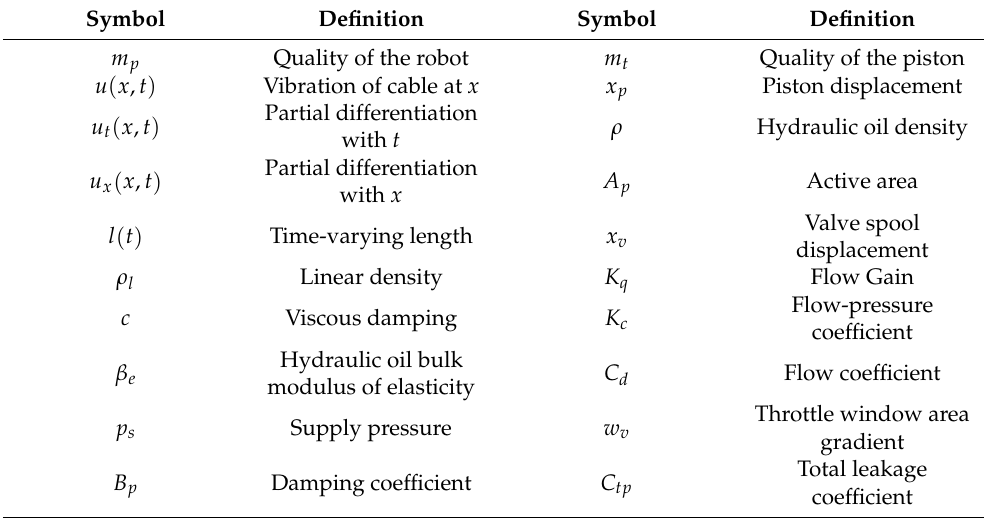
Table 1. System parameter